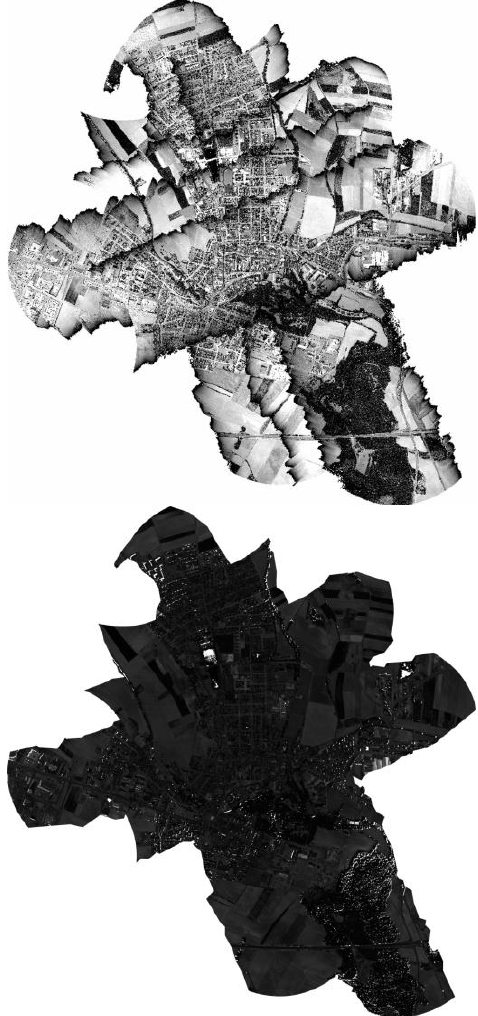
Figure 2. Upper image: amplitude image of the 532nm ALS data of the study area (linear scale from 0 (black) to 1000 (white)); Lower image: Calibrated radiometric reflectance at 532nm (linear scale from 0 (black) to 1 (white)).